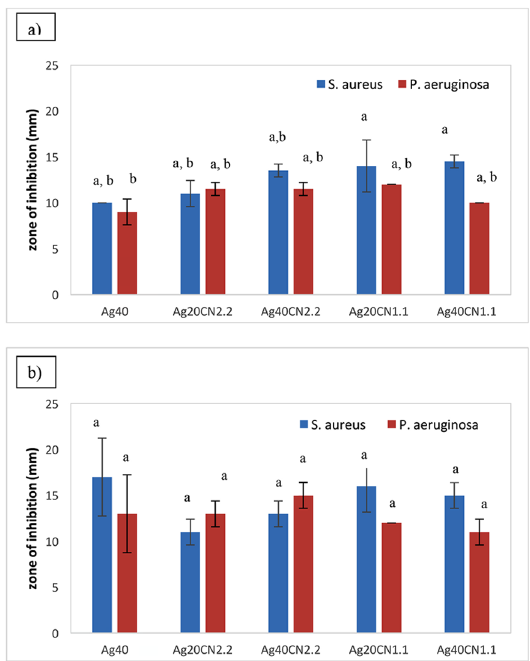
Figure 12. Antibacterial activity of the CB membranes thermally treated in the autoclave (a) and oven (b) in the presence of different concentrations of AgNPs and Ce(NO3)3, against the Gram-positive Staphylococcus aureus and Gram-negative bacteria Pseudomonas aeruginosa . *Averages that do not share a letter are significantly